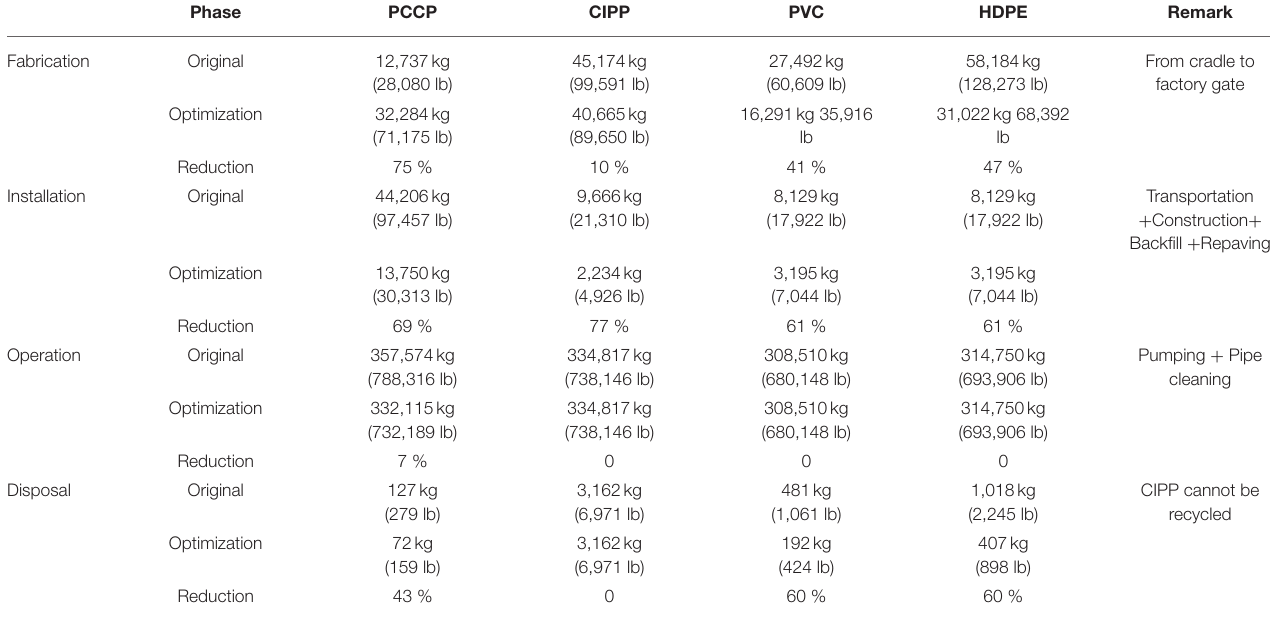
TABLE 9 | Carbon emissions during the life cycle of pipeline before and after optimization. Phase PCCP CIPP PVC HDPE